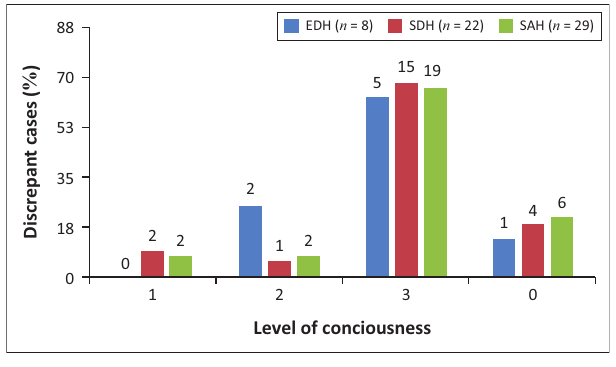
FIGURE 1: Discrepancies and level of consciousness, South Africa, 2014–2016. 1 = mild (GCS 15–13), 2 = moderate (GCS 12–9), 3 = severe (GCS ≤ 8), 0 = unspecified.